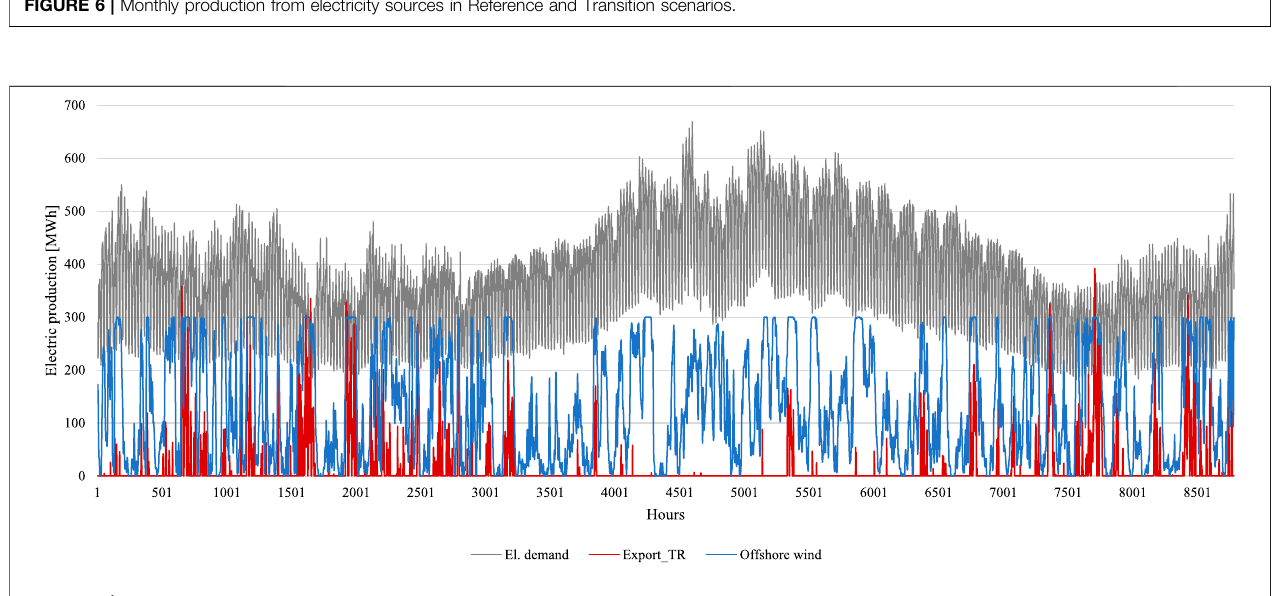
FIGURE 6 | Monthly production from electricity sources in Reference and Transition scenarios.